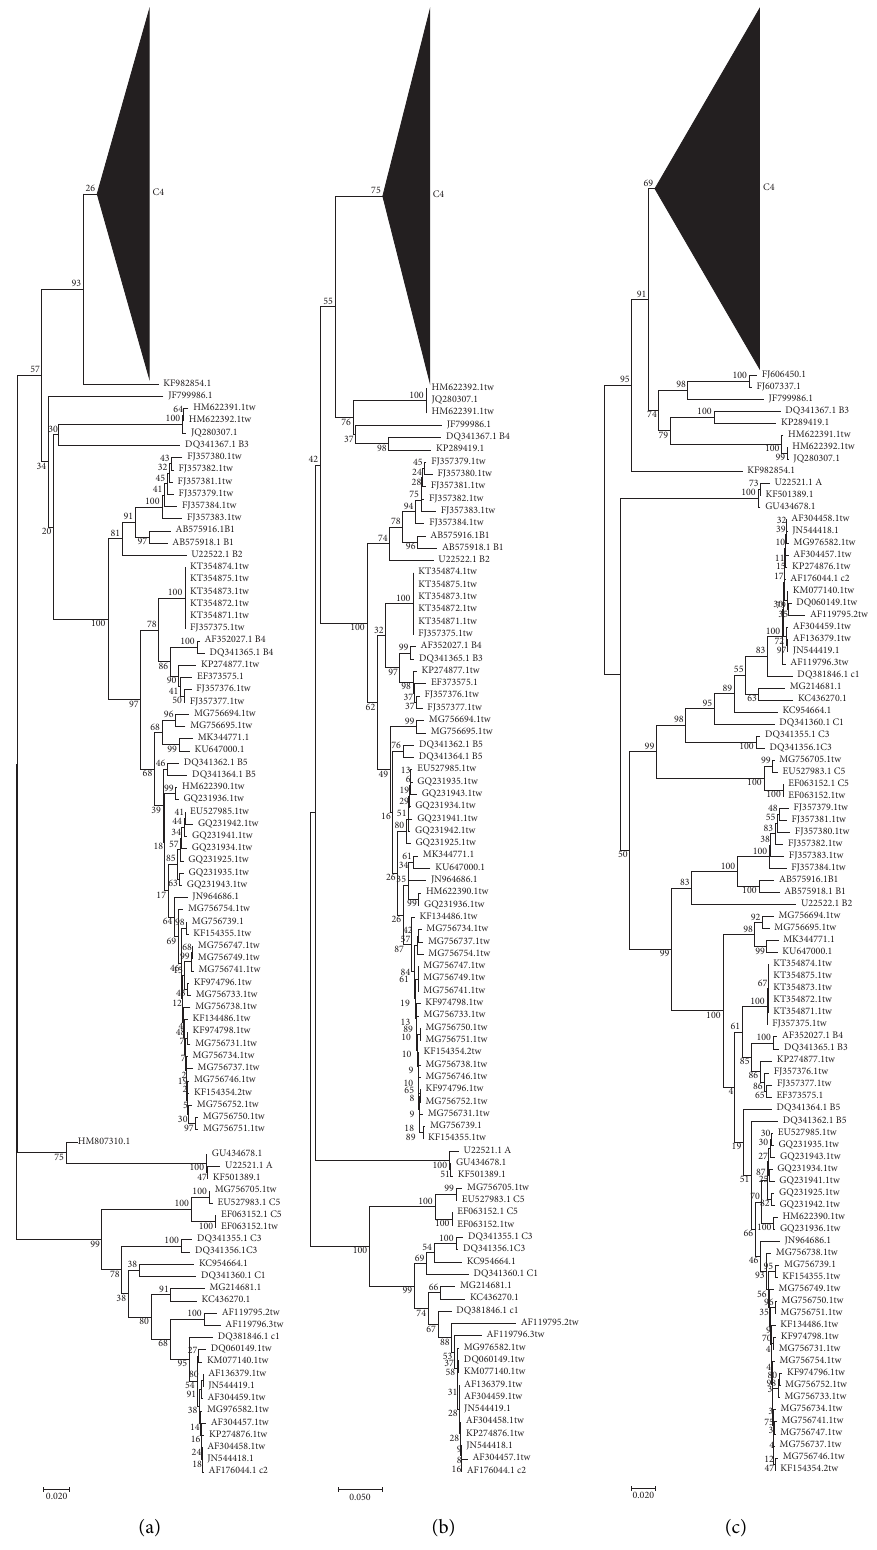
Figure 5: Phylogenetic trees constructed with 2C, 3C, and 3D of EV-A71. (a) 2C phylogenetic tree; (b) 3C phylogenetic tree; (c) 3D phylogenetic tree. The C4 subtree was compressed. Each strain is named according to the GenBank accession number. Taiwan’s strains have a TW suffix, and the reference strains have corresponding subtype name